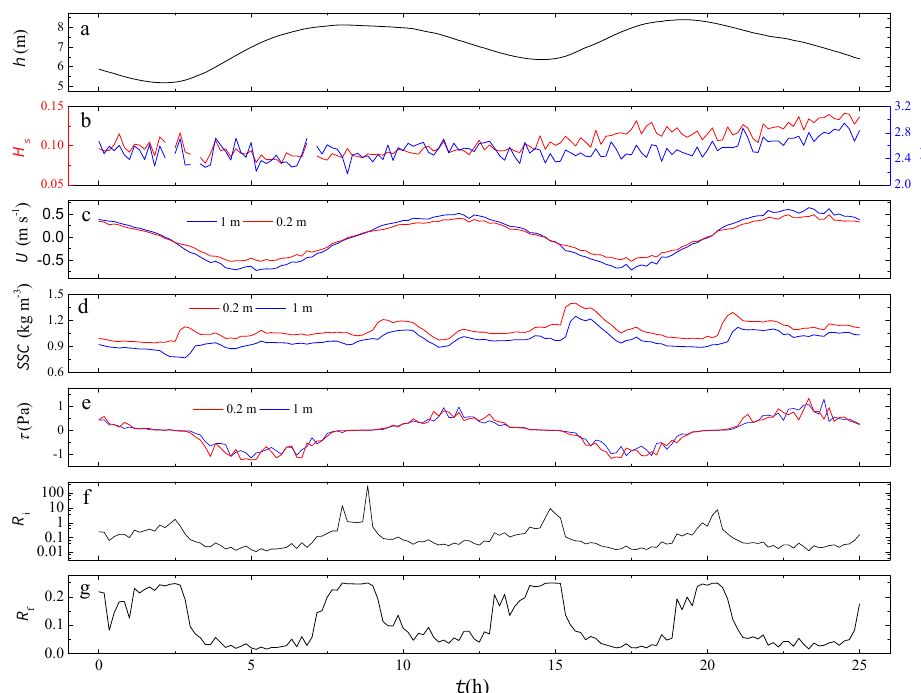
Figure 2. Time series of the bottom boundary layer parameters. ( a ) Water depth ( h ); ( b ) significant wave height ( H s ) and their mean period ( T m ); ( c ) current velocity ( U ) in the main flow direction at 0.2, 1 m asb; ( d ) suspended sediments concentration ( SSC ) at 0.2, 1 m asb; ( e ) Reynolds stress ( τ ) in the main flow direction at 0.2, 1 m asb; ( f ) gradient Richardson number (R i ) at 0.6 m asb; ( g ) flux Richardson number (R f ) at 0.6 m asb. The positive direction is 10 ◦ counterclockwise from the north, for both current velocity ( U ) and Reynolds stress ( τ ).